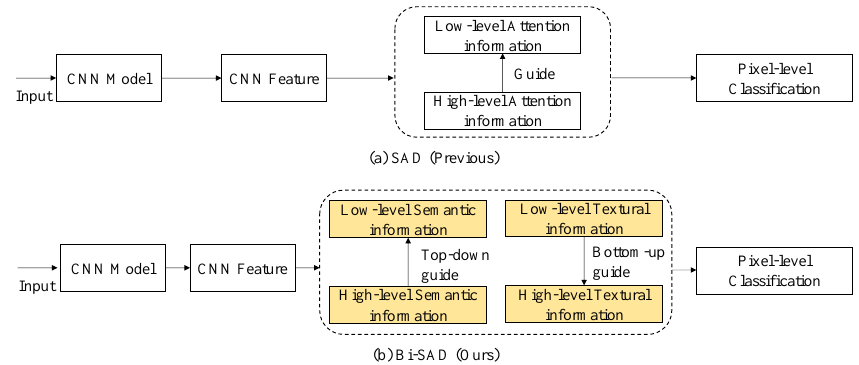
Figure 1. The illustration of the detection pipeline. ( a ) Self-Attention Distillation (SAD) is a self-attention distillation method. It introduces a layer-wise attention distillation within the network itself to improve the performance the model. ( b ) Bidirectional Self-Attention Distillation (Bi-SAD) is our bi-directional attention distillation method. It uses the bottom-up textural information distillation to get more detailed cloud boundaries and the top-down semantic information distillation to get more reliable